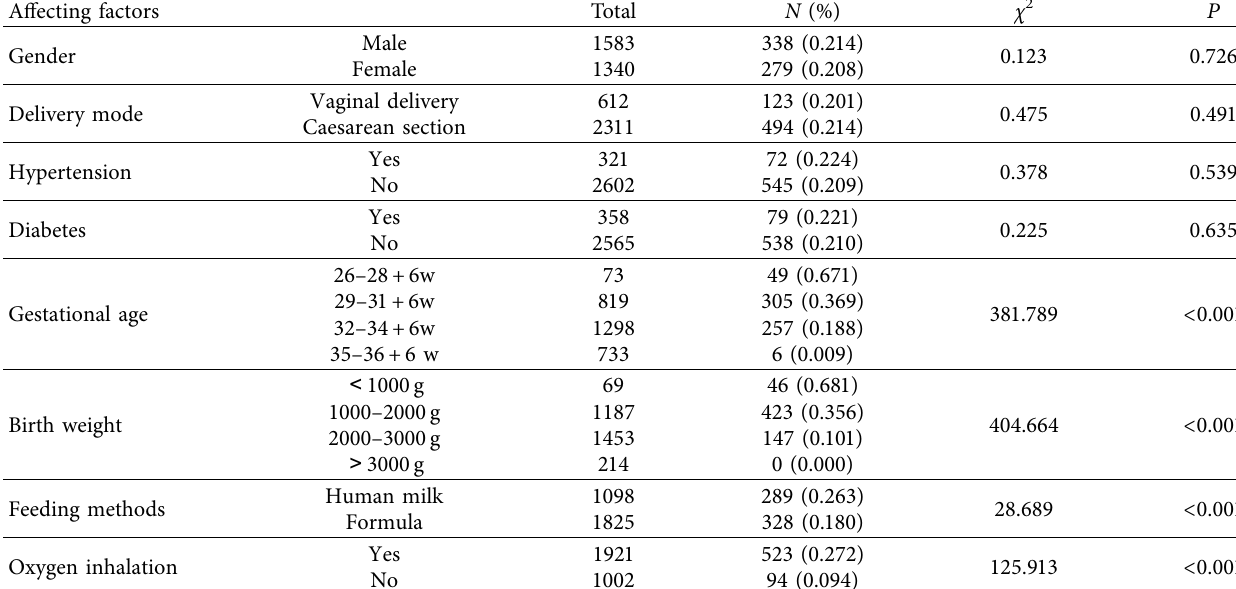
Figure 3: ROP found in premature newborns. (a) Grade I ROP in a newborn with gestational age of 29 weeks +5 days. (b) Grade II ROP in a newborn with gestational age of 28 weeks+ 3 days. (c) Grade III ROP in a newborn with gestational age of 27 weeks+ 6 days. (d) Plus disease ROP in a newborn with gestational age of 26 weeks+4 days. Table 4: Factors affecting ROP in premature infants by univariate